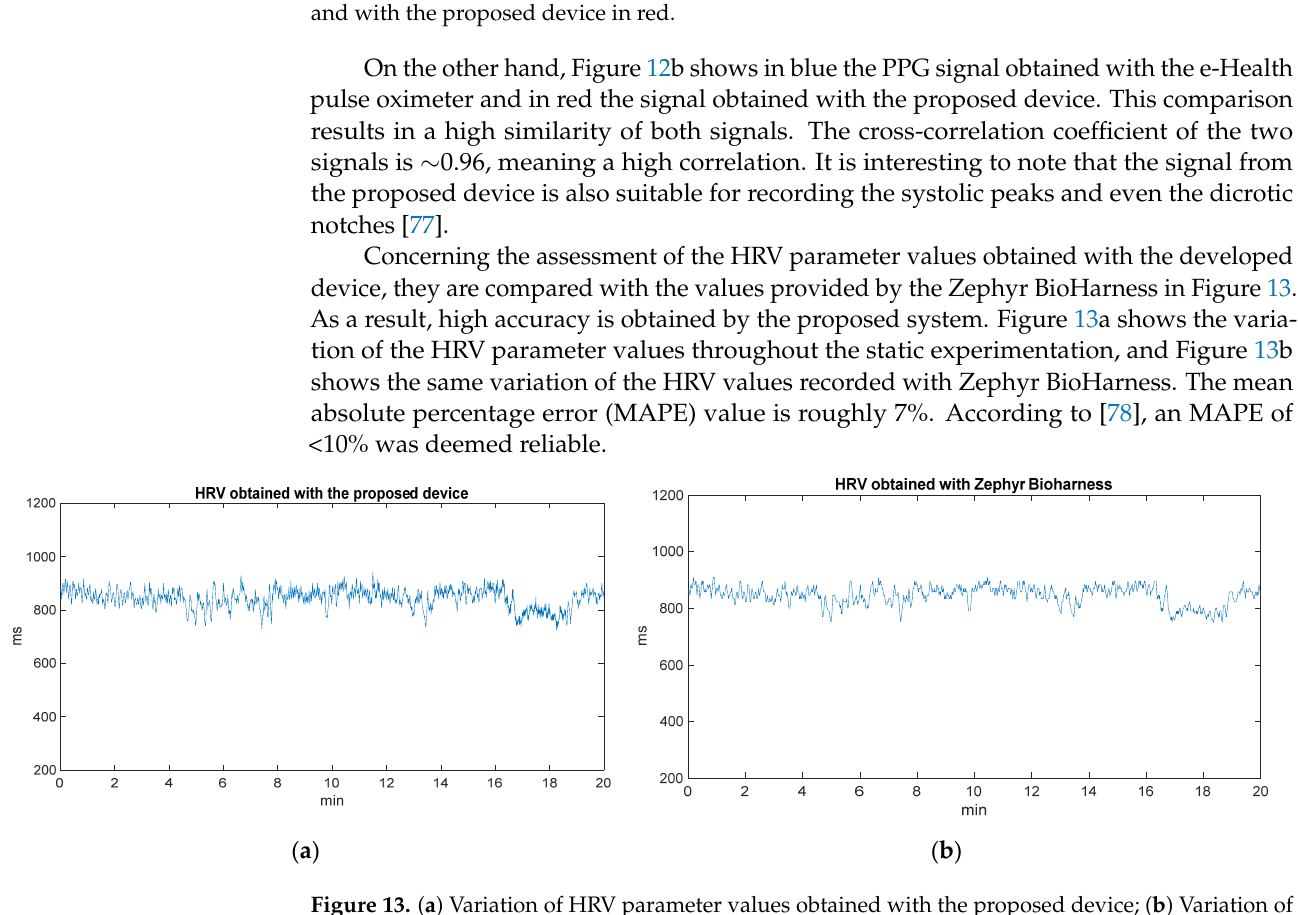
Figure 12. ( a ) ECG signal obtained with Zephyr BioHarness in blue, with ‐ Health in dark and ECG with the proposed device in red; ( b ) PPG signal obtained with the e ‐ Health pulse oximeter in blue and with the proposed device in red.